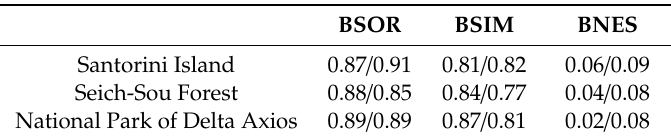
Figure 4. Venn diagrams, illustrating the number of unique and shared OTUs among the total of rhizosphere and phyllosphere samples, and the rhizosphere and phyllosphere samples of each plant. See Table 1 for coding assignments. Table 2. Values for beta-diversity (bSOR), turnover (bSIM) and nestedness (bNES) for rhizosphere and phyllosphere bacterial communities of all plants in each sampling site. Bold values indicated the phyllosphere bacterial